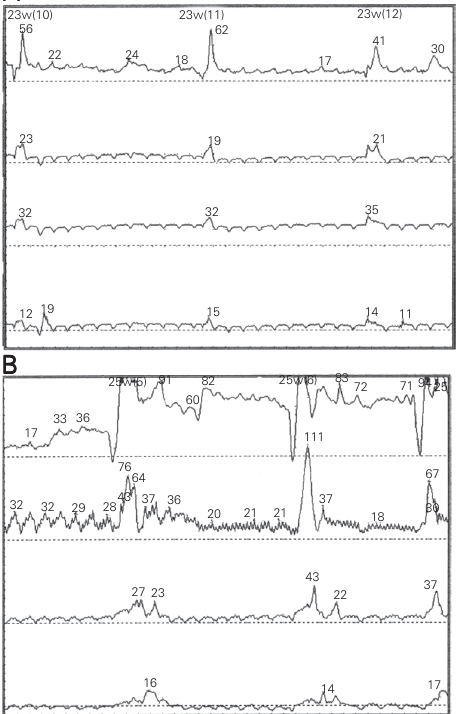
Table 2. Results of manometry, with comparison of the caustic group with absent peristalsis and the control group and between operated and non-operated children from the caustic